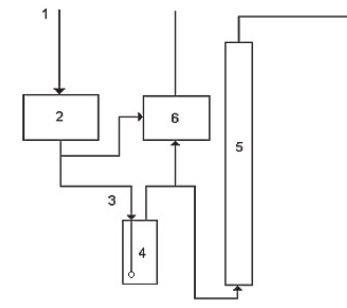
Fig. 1 – Schematic of ozonation reactor, 1 – oxygen inlet, 2 – ozone generator, 3 – mixture of O 2 and O 3 , 4 – ozonation reactor with frit, 5 – destruction of residual ozone, 6 – detector of